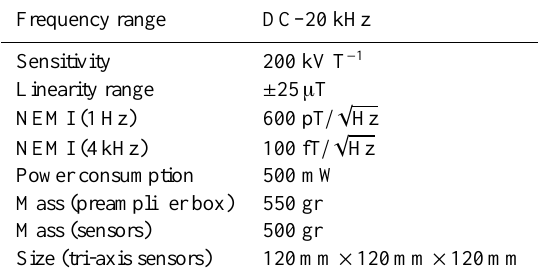
Figure 10. (a) Performances of the tri-axes hybrid magnetometer. The intrinsic sensitivity S I has been measured when the sensor axis is perpendicular to an external DC magnetic field (black curve) and when it is either parallel or anti-parallel (yellow and magenta curves) , more precisely 20log( S I ) is plotted in frame (a) , frame (b) demonstrates the linearity of the sensor with respect to the external DC magnetic field, frame (c) shows the transfer functions 20log(Gain), Gain being measured in V / nT , frame (d) is a plot of the Noise Equivalent Magnetic Induction in T / sqrt(Hz) between 0.3Hz and 50Hz in green for the GMI part (the peak at 50Hz being due to the network power supply) and between 10Hz and 50kHz in blue for the induction sensor part. Table 1. Performance of the tri-axes hybrid magnetometer combin- ing a search coil and a wire-wound